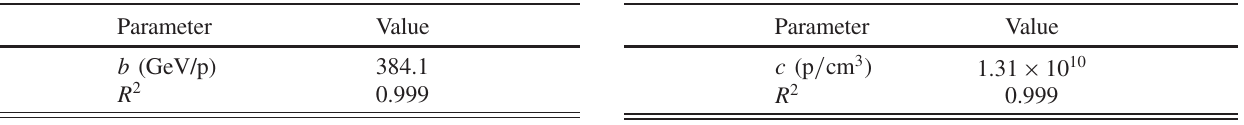
TABLE IX. Fit parameters for the curve in Fig.